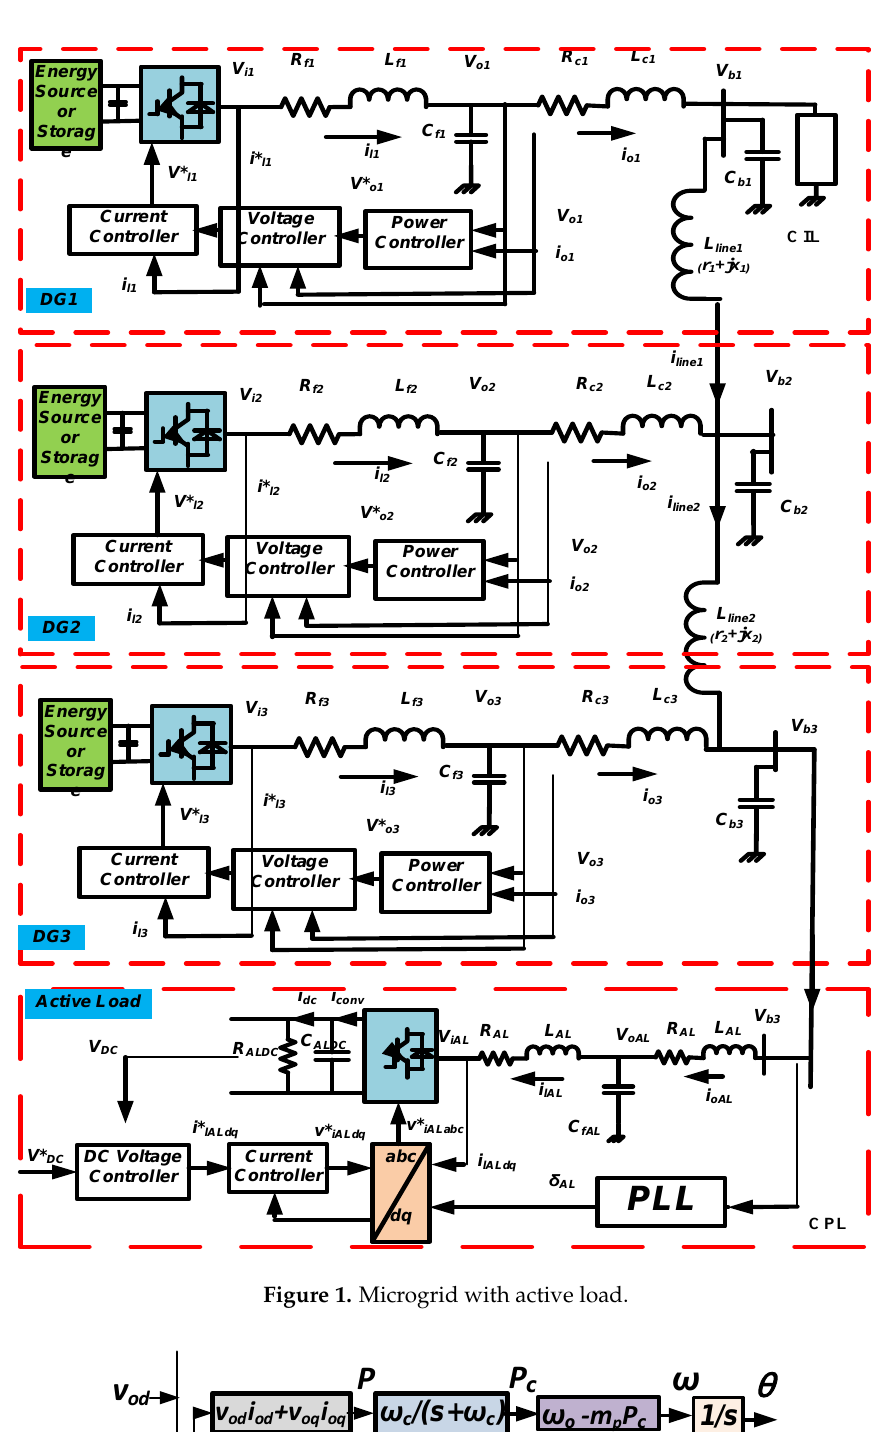
Figure 1. Microgrid with active load.